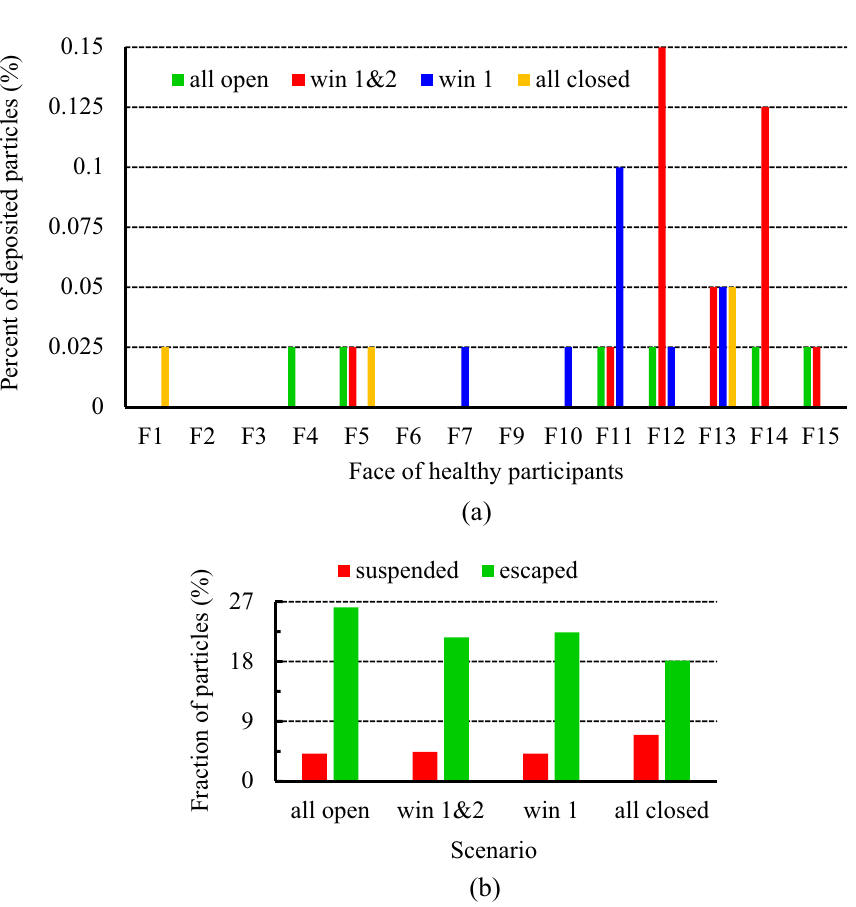
Figure 13. Effects of the exhaust capacity on the exposure risk of healthy participants during various scenarios; ( a ) the fraction of the particles deposited on the healthy individuals’ faces, and ( b ) the fraction of the suspended and escaped particles at the end of particle